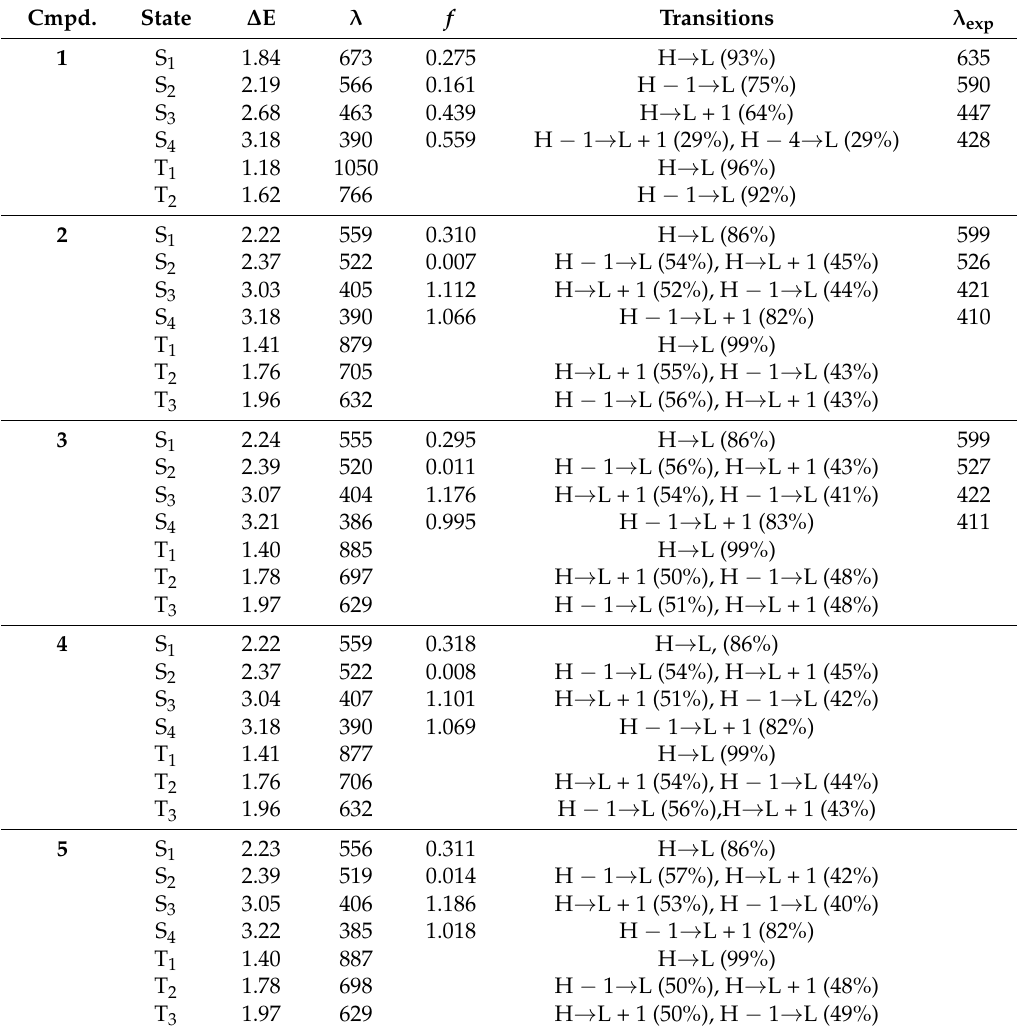
Table 1. B3LYP/6-31 + G * vertical excitation energies, ∆ E (eV), λ (nm), oscillator strengths f and main transitions (H = HOMO, L = LUMO) for studied compounds, computed in dichloromethane. Experimental values are taken from [13].